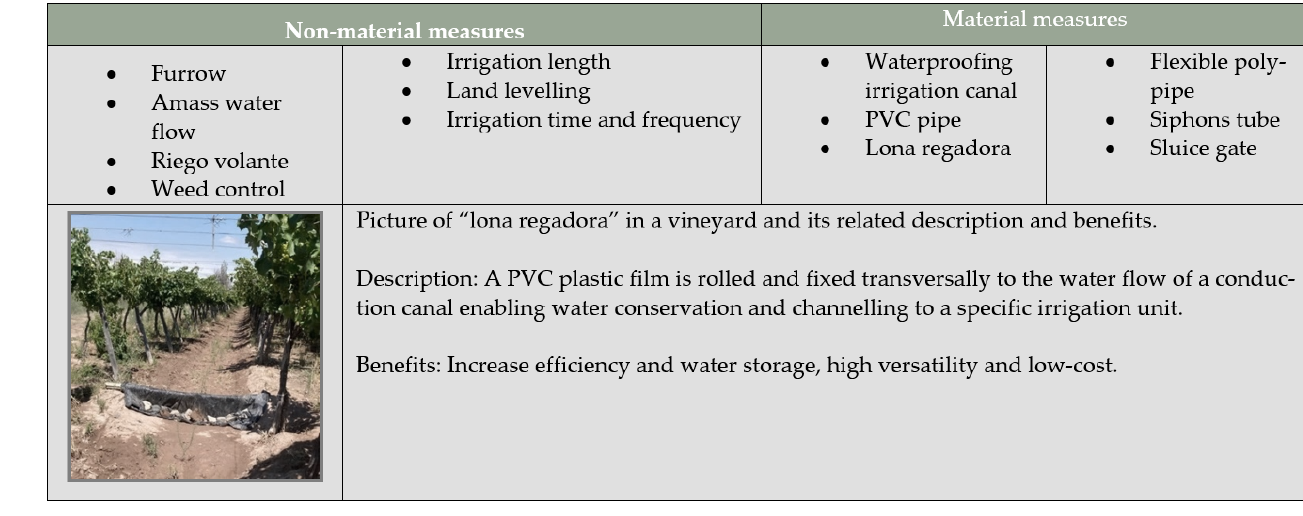
Figure 4. List of material and non-material measures of reasonable efficiency and example of “lona regadora” [38]. regadora”